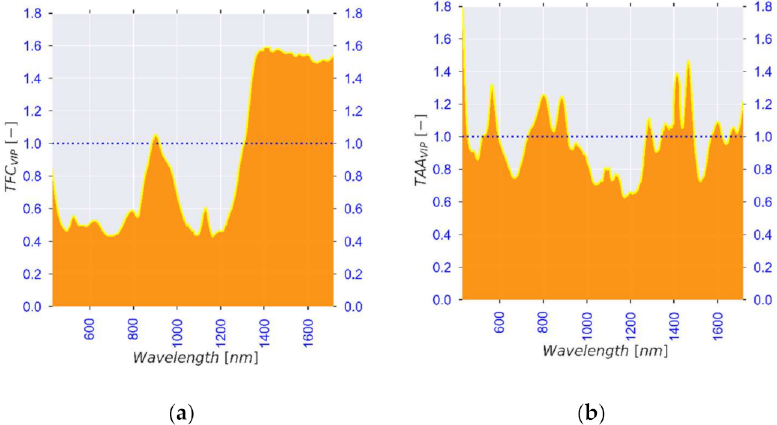
Figure 8. VIP plots for ( a ) TFC and ( b )